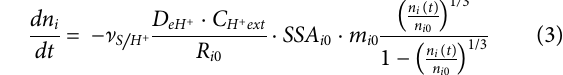
Frontiers in Chemical Engineering |